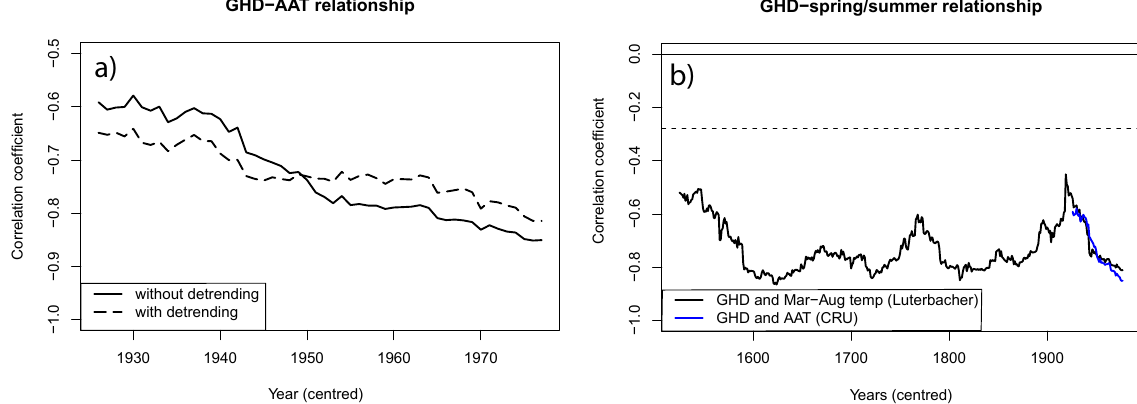
Fig. 7. (a) Running correlation of the GHD with the France AAT time series from CRU (1901–2002). Dashed line: correlation of detrended time series. (b) Running correlation of the GHD with the France spring–summer temperature from Luterbacher et al. (2004) (1500–2002). Blue line: GHD-AAT correlation (CRU). The length of the time window is 50 years. The significance level ( p =0.05) is at ρ = − 0.28 – dashed line in panel (b) .